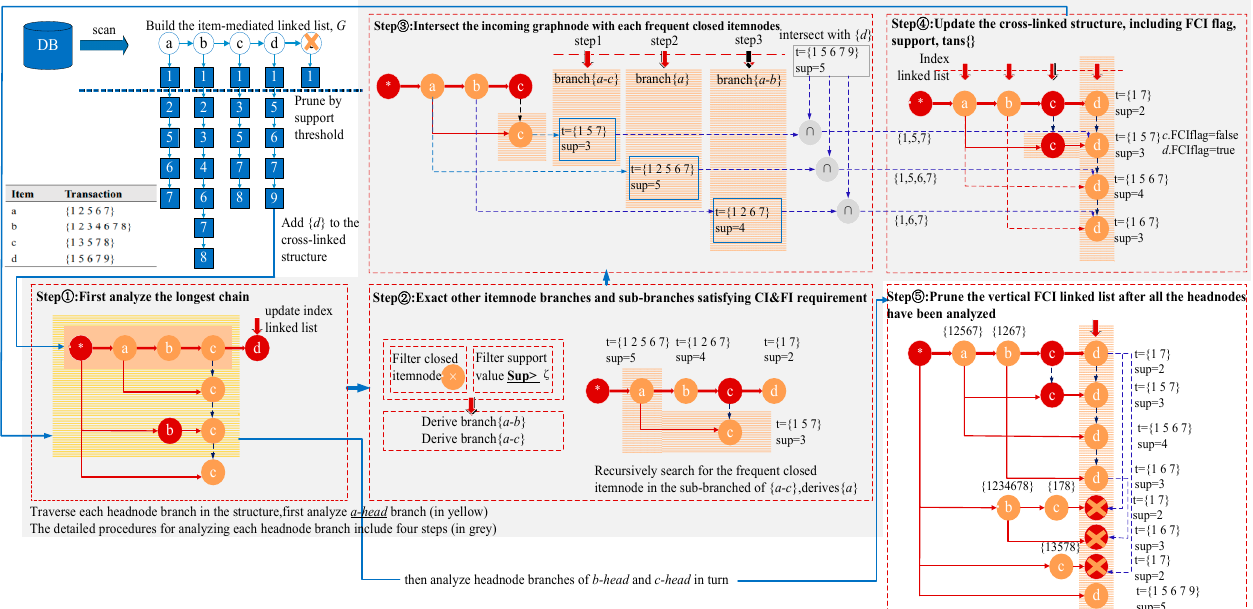
Figure 7. Detailed procedures for the cross-linked structure updating mechanism. (sup: support value, t: transaction set).